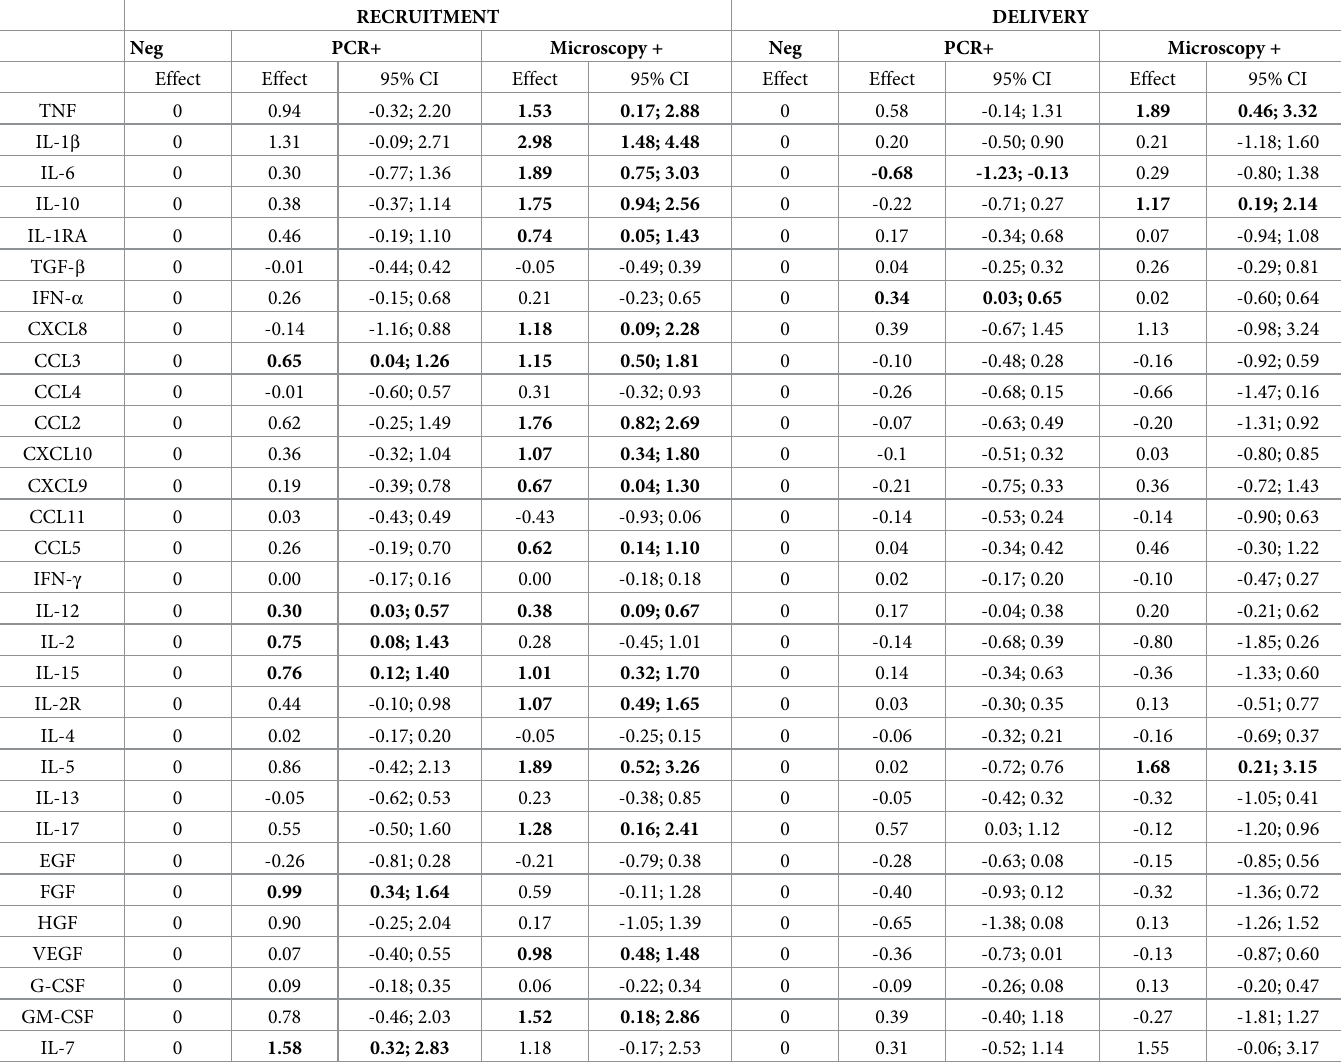
Table 4. Association of plasma biomarker concentration with microscopic and submicroscopic P . vivax